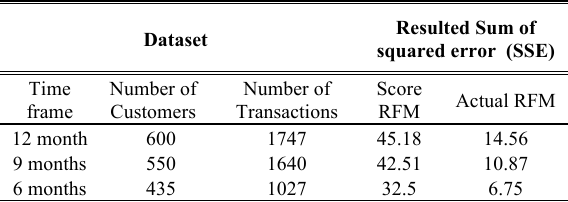
TABLE V. WITHIN CLUSTER SSE COMPARISON Resulted Sum of Dataset squared error